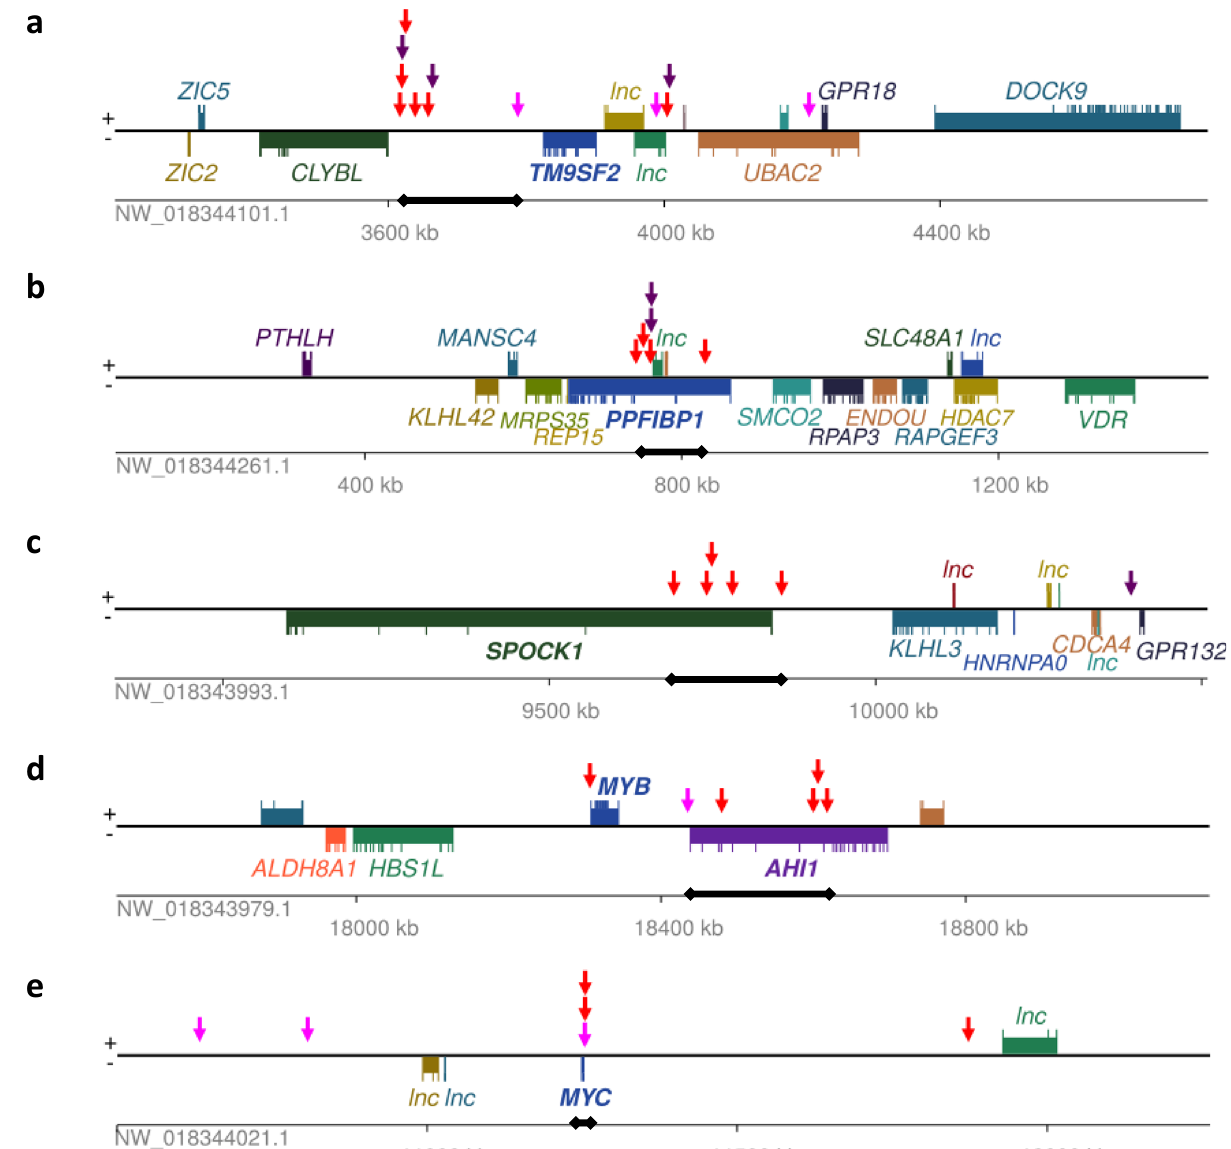
Fig. 4 Regions with signi fi cantly high IS density (hotspots) in the koala genome. IS locations are shown with arrows. Regions longer than the identi fi ed hotspot windows are displayed to show the surrounding genes; locations of hotspots are indicated by thick back line on contig scale bar. Long non-coding RNAs are labelled “ lnc ” and genes without annotation are unlabelled. All regions contain multiple IS that are found in both healthy and tumour tissue (ERVs) (red arrows). Regions ( a – c ) contain IS that are conserved in multiple koalas (purple arrows). Regions ( a , d , e ) contain tumour-speci fi c IS (pink arrows). All regions contain genes with associations to cancer, namely a , TM9SF2 ; b , PPFIBP1 ; c , SPOCK1 ; d , AHI1 and MYB ; e , MYC . There may also be positive bene fi ts for increased expression of some genes in these regions; for example, a also contains a gene involved in vitamin metabolism ( CLYBL ), and the cancer genes PPFIBP1 , SPOCK1 and AHI1 in regions b – d , respectively, have roles in body weight and feeding behaviour. Two other identi fi ed hotspots are not shown here because they were not in close proximity to protein coding genes: one was surrounded by non-coding RNAs and the other was at the very start of a contig (see Supplementary Table